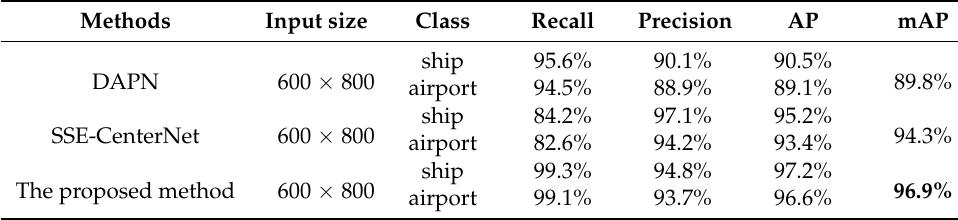
Table 6. Comparison with target detection methods in the SAR